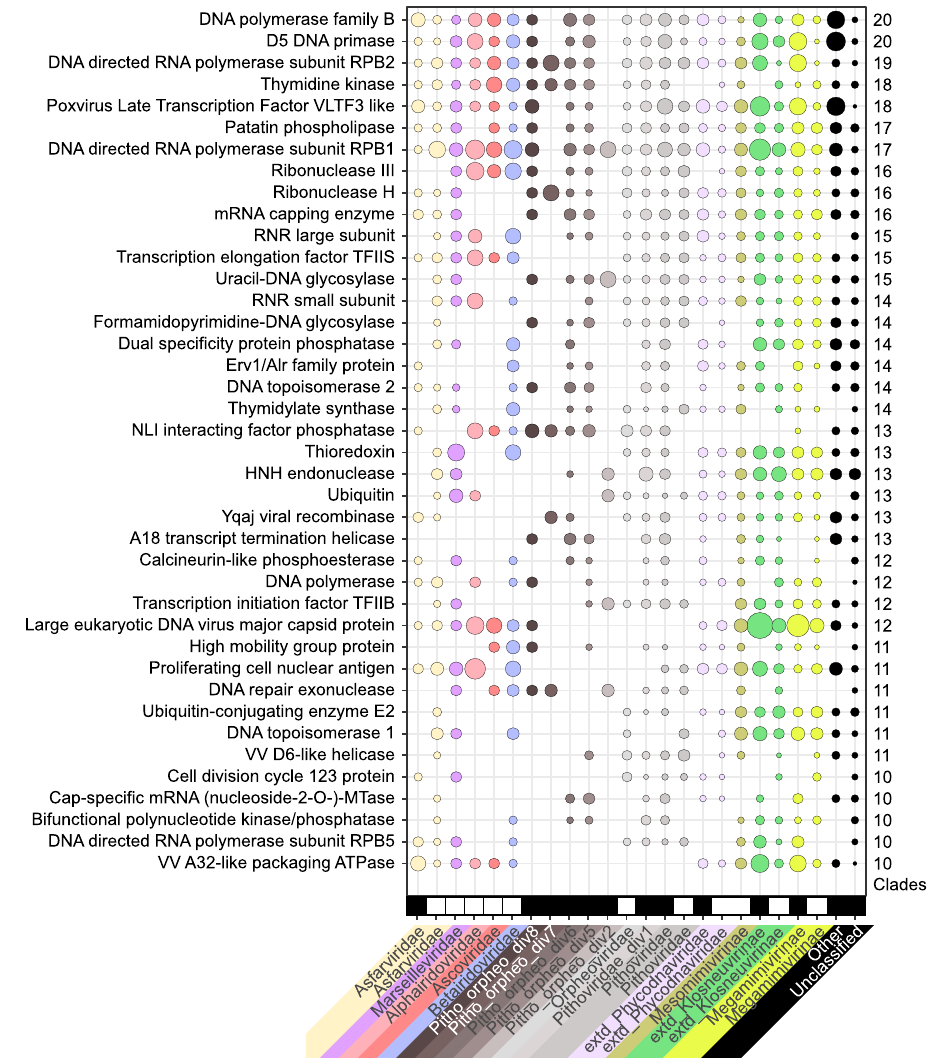
Fig. 5 | Comparison of most shared functions among metagenomic and refer- ence Nucleocytoviricota families. Functionswereselectedamongtheannotations foundinatleast10clades.Metagenomicsequencesaremarkedasblackrectangles at the bottom of the plot while blank spaces correspond to reference genomes. Groups with less than 250 ORFs were marked as “ Other ” . The size of the bubbles